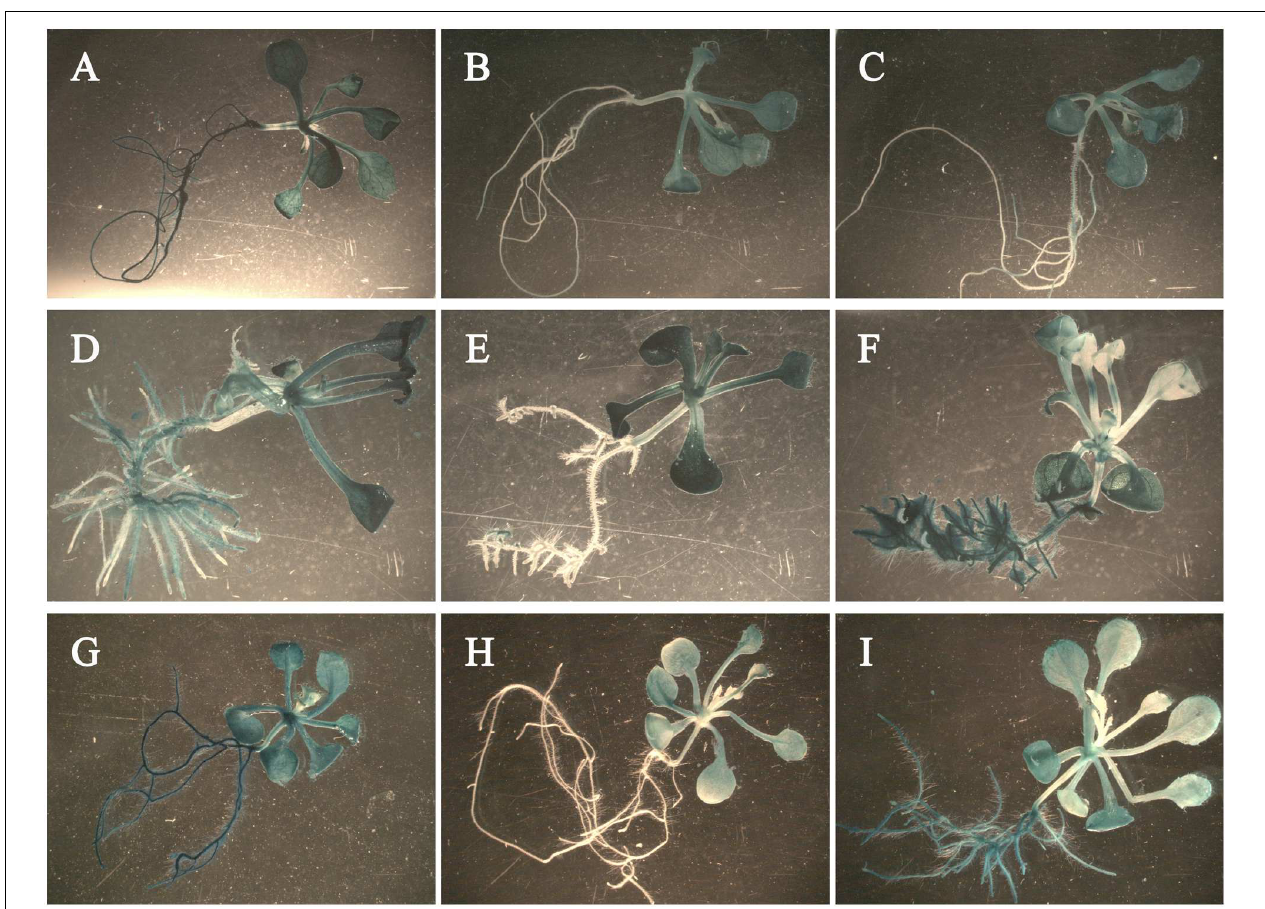
FIGURE 6 | The histochemical staining of phyto-hormone-treated transgenic Arabidopsis seedlings. pB1a represents promoter of Rht-B1a , pB1i-1 represents promoter of Rht-B1i-1 . (A–C) Arabidopsis seedlings treated with GA 3 : (A) 35S::GUS transgenic Arabidopsis seedling, (B) pB1a::GUS transgenic Arabidopsis seedling, (C) pB1i-1::GUS transgenic Arabidopsis seedling. (D–F) Arabidopsis seedlings treated with IAA: (D) 35S::GUS transgenic Arabidopsis seedling, (E) pB1a::GUS transgenic Arabidopsis seedling, (F) pB1i-1::GUS transgenic Arabidopsis seedling. (G–I) Arabidopsis seedlings treated with IAA/GA 3 : (G) 35S::GUS transgenic Arabidopsis seedling, (H) pB1a::GUS transgenic Arabidopsis seedling, (I) pB1i-1::GUS transgenic Arabidopsis